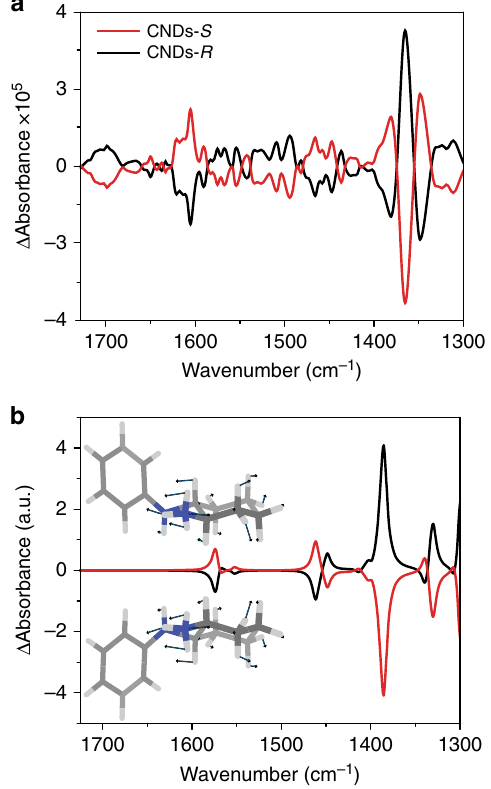
Fig. 4 Comparison between experimental and calculated VCD spectra. a Experimental VCD spectra in water at 298 K of CNDs- S (red line) and CNDs- R (black line); b simulated VCD spectra obtained from DFT calculations of the cyclohexanediamine fragments (performed using the B3PW91 functional and a 6 – 31 G** basis set, water PCM solvation) with the insets showing the main displacement vectors for the computed